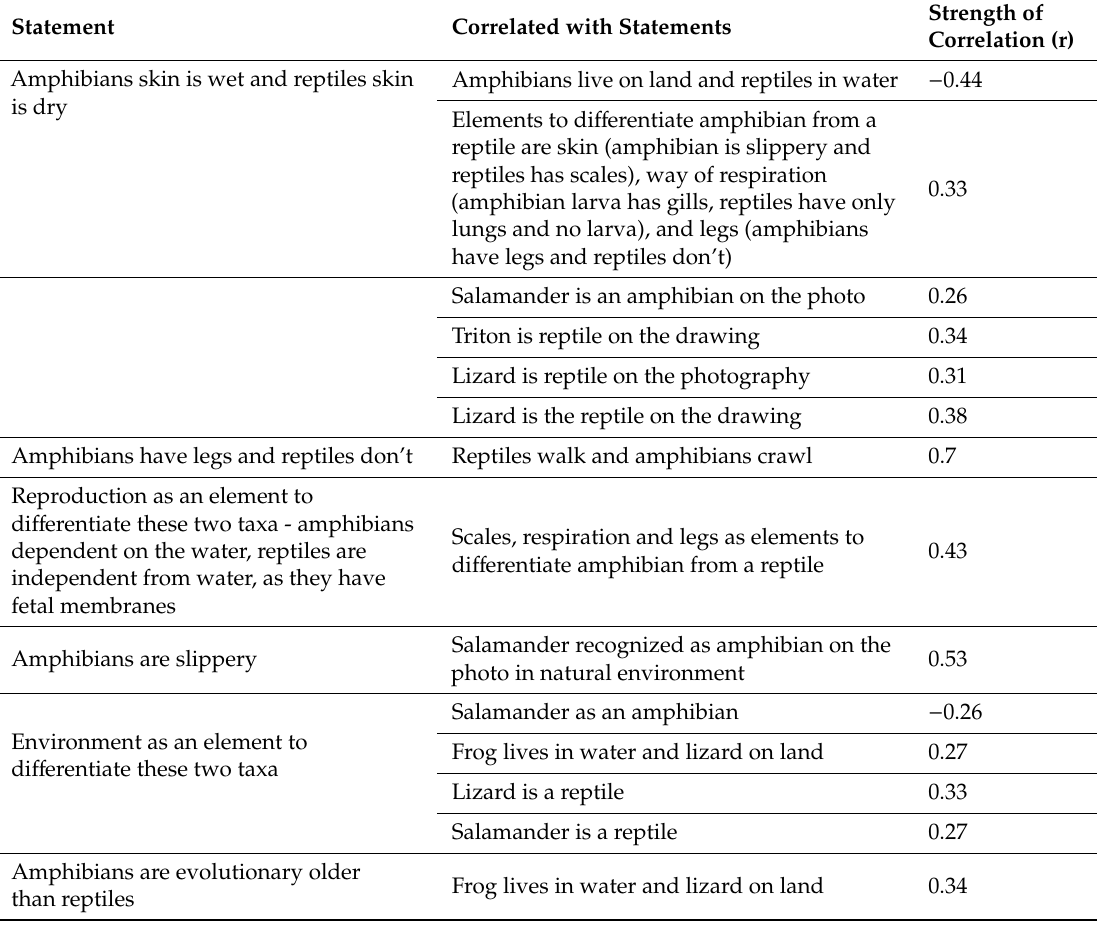
Table A2. Correlations between statements which appeared in in-depth interviews before